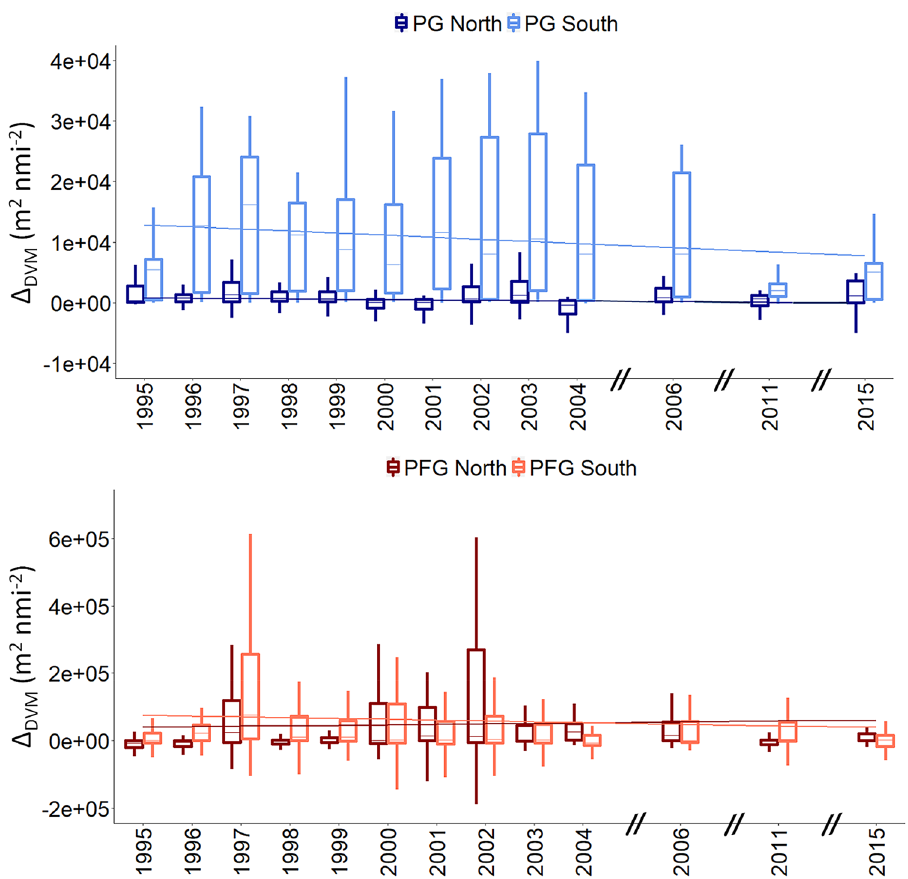
Figure 7. Differences to day and night acoustic density (Delta DVM, expressed in Nautical Area Scattering Coefficient noted NASC or s A , m 2 nmi −2 ) for (top) the plankton group and pelagic fish group (bottom) echo classes in the areas north and south of Cap Blanc.